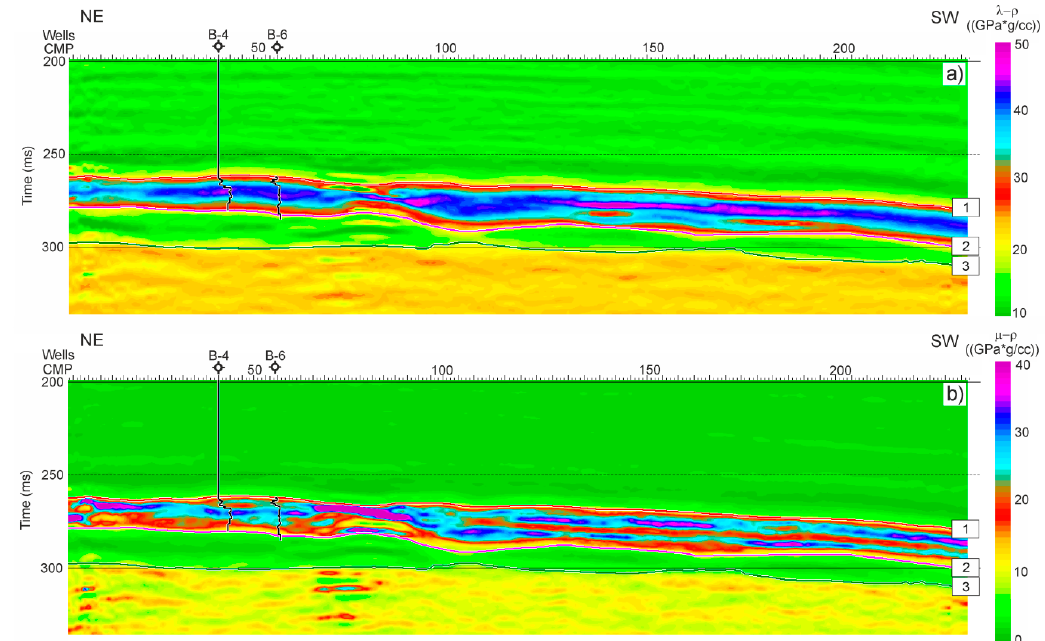
Figure 12. Part of the profile 2 showing zone of interest as: ( a ) λ − ρ , ( b ) µ − ρ . Well logs indicate sulfur content (%). Well B-6 is projected into the profile with 25 m offset. High values of λ − ρ may indicate sulfur concentration and the highest values of µ − ρ may indicate a stiffer rock, probably limestone. The image of µ − ρ is more detailed than both volumes of P- and S-Impedances regarding lithology changes. Horizons 1 and 2 are, respectively, the top and bottom of the evaporitic formation; horizon 3 is the top of the Cretaceous